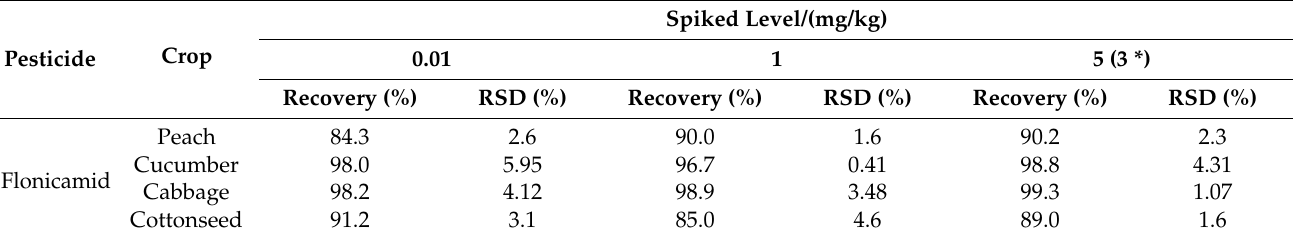
Table 3. Recoveries and RSDs of flonicamid in different crops (n = 5).